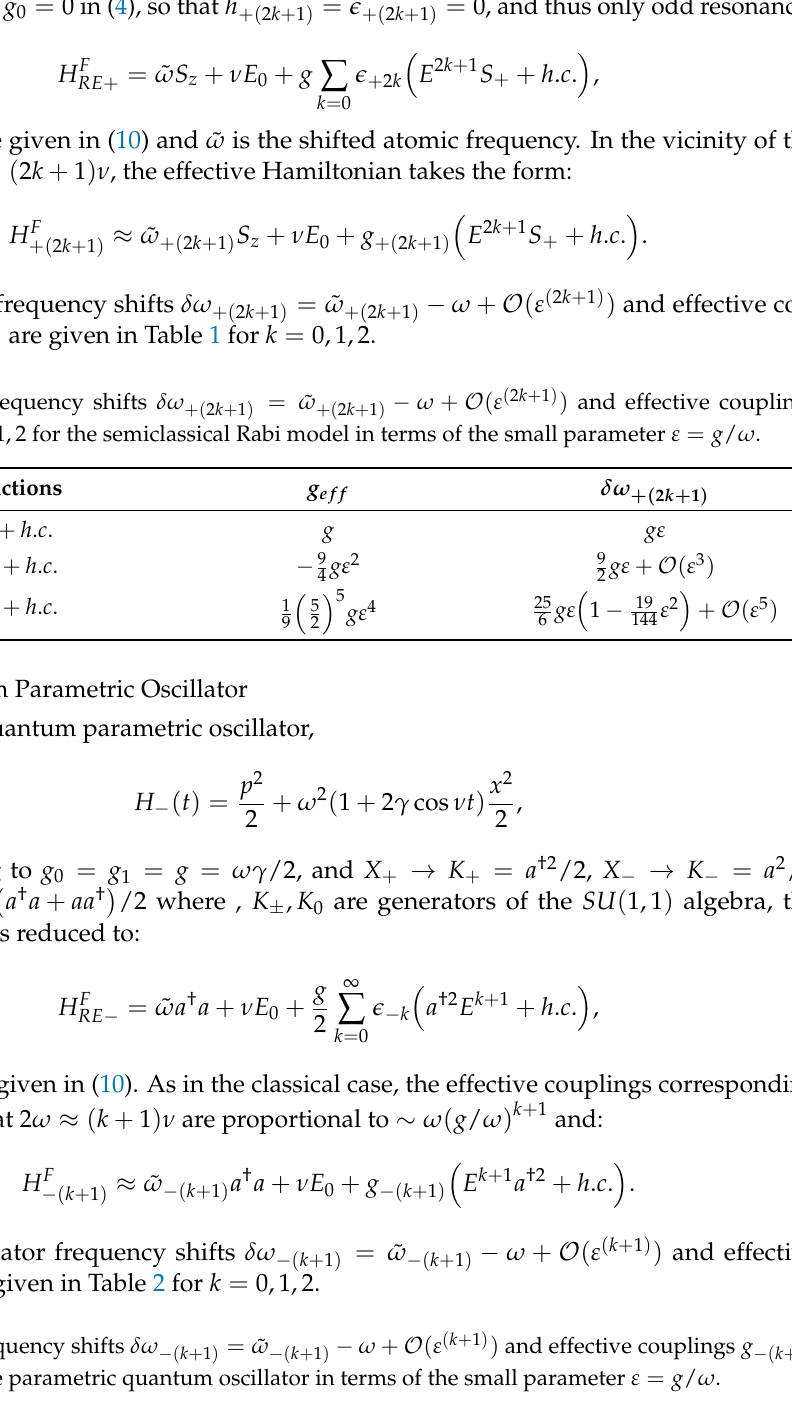
( k + 1 ) ) and effective couplings g Table 2. The frequency shifts δω ( k + 1 ) = ˜ ω ( k + 1 ) − ω + O ( ε − − k = 0,1,2 for the parametric quantum oscillator in terms of the small parameter ε = g / ω . Interaction g ef f δω − ( k + 1 ) Ea †2 + h . c